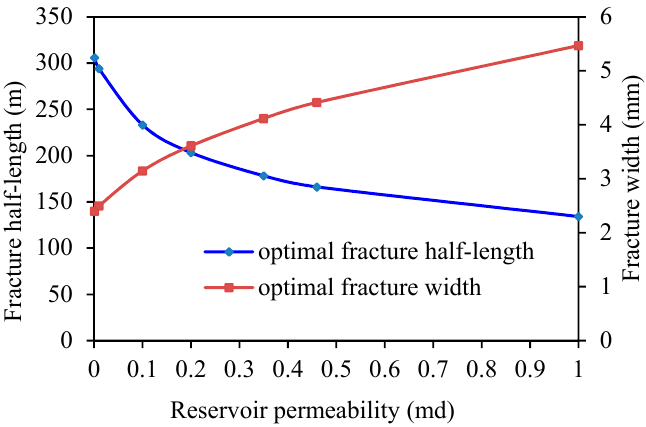
Figure 12. Optimal propped fracture half-lengths and widths vs. reservoir permeability.